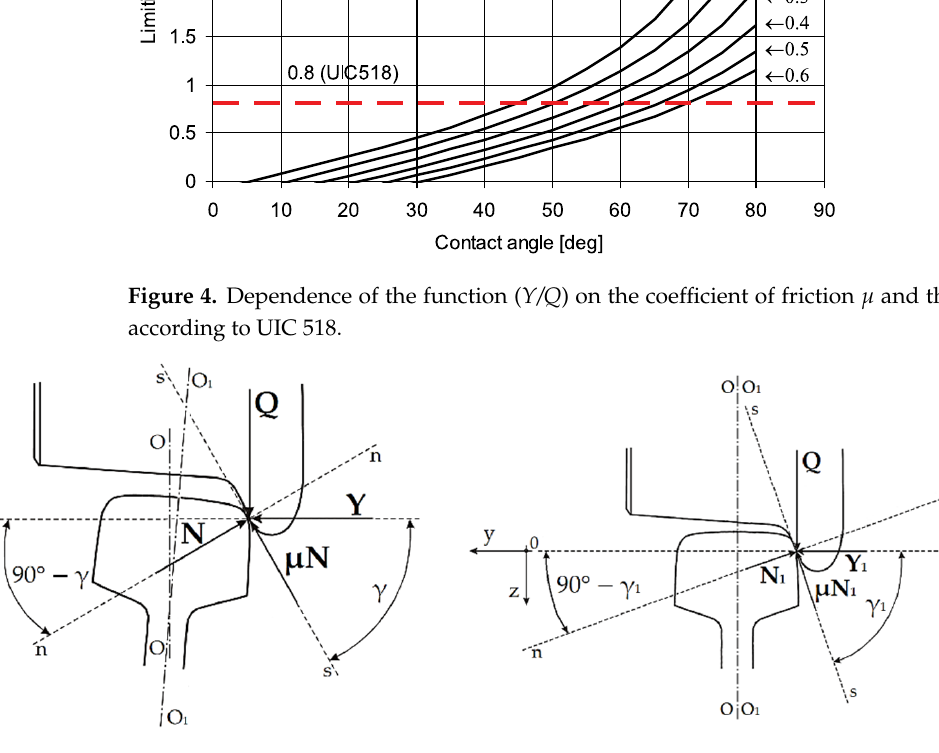
Figure 5. Distribution of forces acting at the point of contact of the wheel with the rail in the case of rail inclination ( a ) and in the case of no rail inclination ( b ).